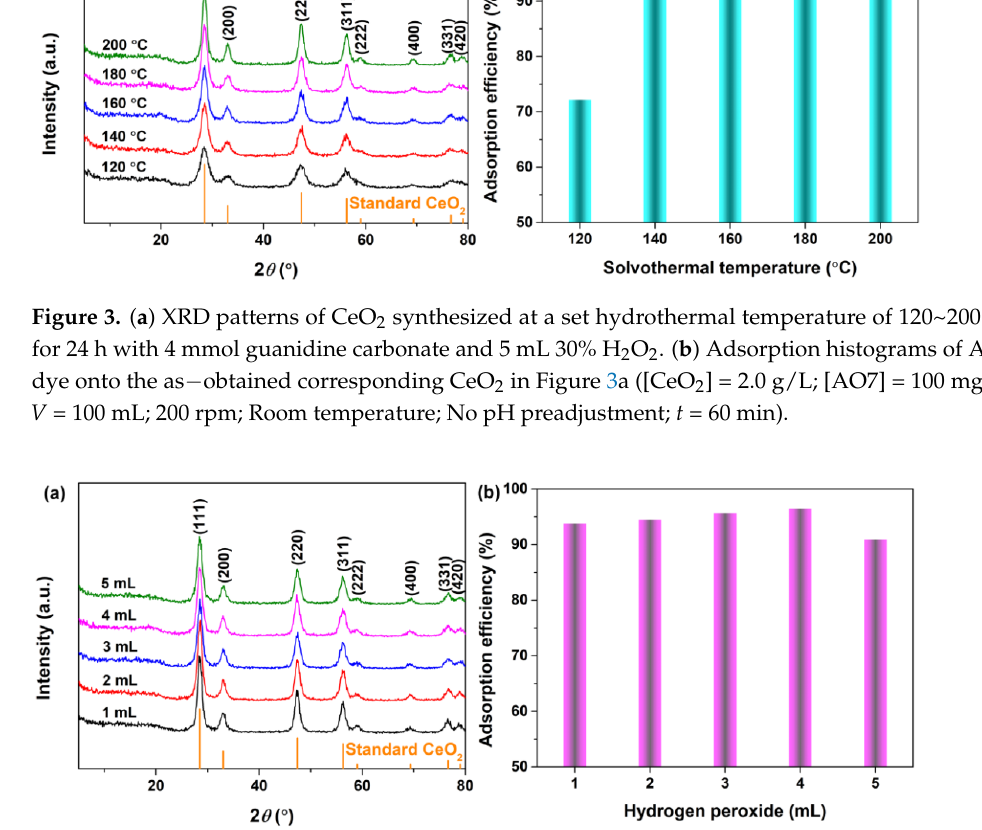
Figure 4. ( a ) XRD patterns of the hydrothermally synthesized CeO 2 at 200 °C 24 h with 4 mmol guanidine carbonate and different additions of 30% H 2 O 2 (1~5 mL). ( b ) Adsorption histograms of AO7 dye onto the as − obtained corresponding CeO 2 in Figure 4a ([CeO 2 ] = 2.0 g/L; [AO7] = 110 mg/L; V = 100 mL; 200 rpm; Room temperature; No pH preadjustment; t = 60 min).